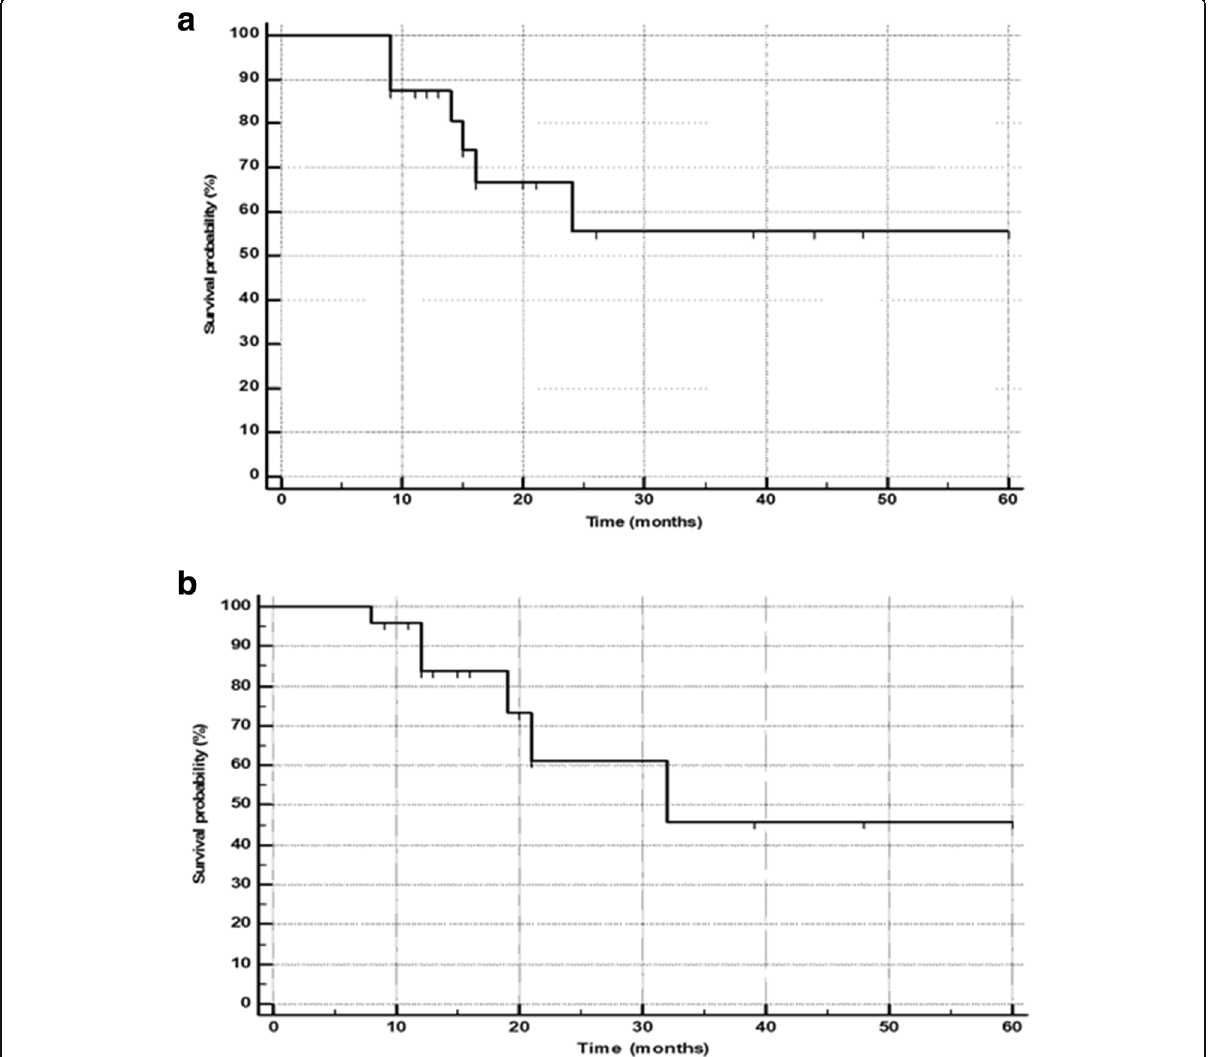
Fig. 2 a Kaplan-Meier plots: overall survival function. b Kaplan-Meier plots: progression-free